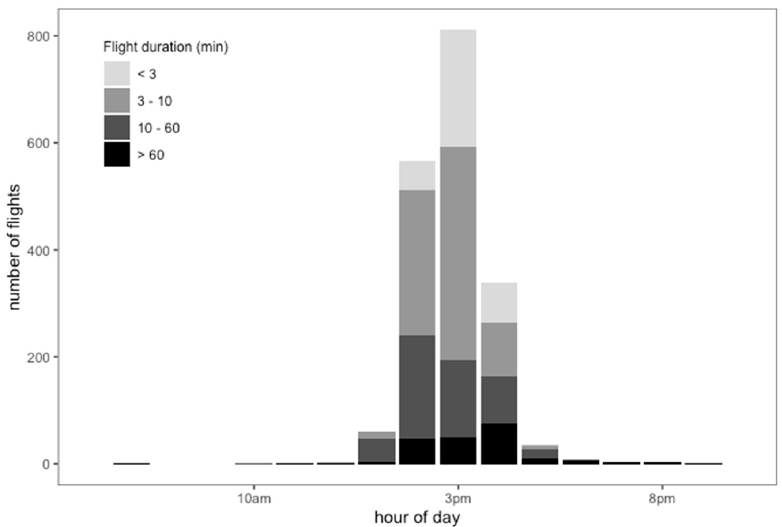
Figure 5. Number of flights according to flight duration in minutes of drones marked with RFID in different hour ranges during the mating season in NW Argentina. different hour ranges during the mating season in NW